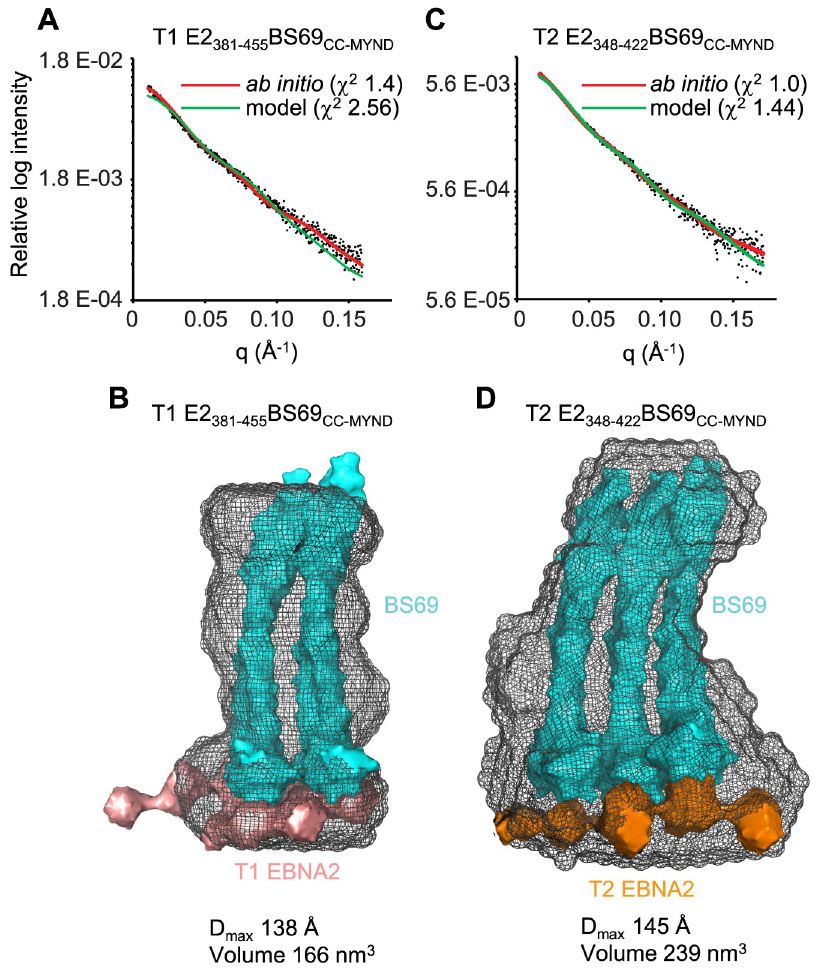
Fig 4. Solution structure of EBNA2-BS69 CC-MYND complexes determined by SAXS. (A) SAXS scattering data for type 1 EBNA2 381-455 -BS69 CC-MYND (black dots) fitted to the ab initio DAMMIN dummy atom model (red line). SAXS scattering data fitted to the docked structural complex shown in B (green) with the χ 2 determined by FoXS. Plots show relative log intensity vs scattering vector (q). (B) Solution structure of type 1 EBNA2 381-455 -BS69 CC-MYND. The SAXS envelopes (grey mesh) were generated by averaging 23 ab-initio models using the DAMMIF programme. The crystal structures of two BS69 CC-MYND dimers (PDB ID: 5HDA) are shown in cyan and were manually docked into the SAXS envelope along with the ab-initio dummy atom SAXS solution structures of two type 1 EBNA2 381-455 polypeptides (salmon). The maximum dimension (D max ) and volume were calculated using Sc Å tter. (C) SAXS scattering data for type 2 EBNA2 348-422 -BS69 CC-MYND (black dots) fitted to the ab initio DAMMIN dummy atom model (red line). SAXS scattering data fitted to the docked structural complex shown in D (green) with the χ 2 determined by FoXS. (D) Solution structure of type 2 EBNA2 348-422 -BS69 CC-MYND obtained as described in (B). The crystal structures of three BS69 CC-MYND dimers (PDB ID: 5HDA) are shown in cyan and were manually docked into the SAXS envelope along with the ab-initio dummy atom SAXS solution structures of two type 2 EBNA2 348-422 polypeptides (orange).